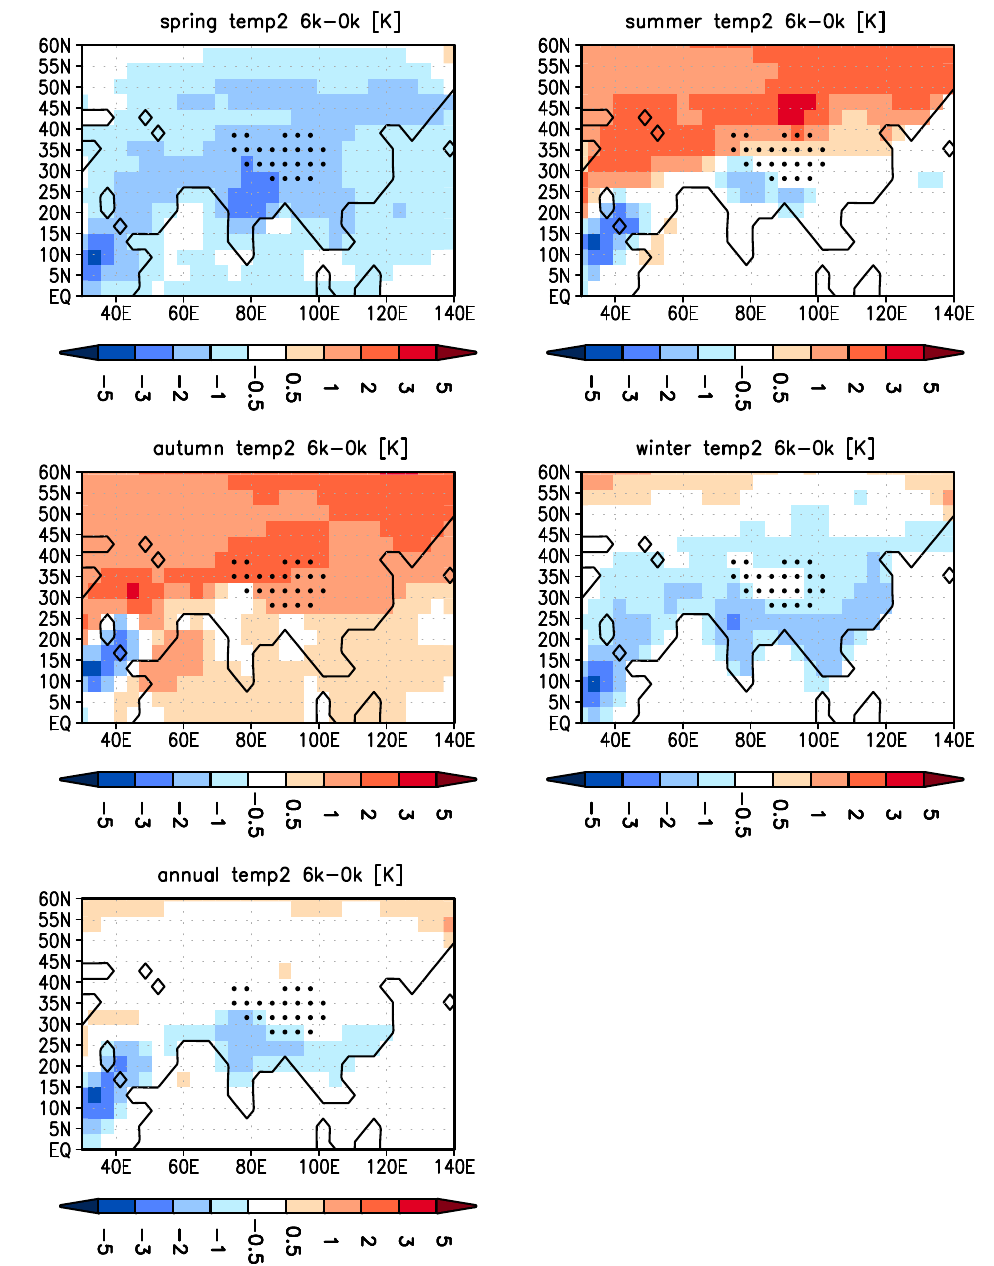
Fig. 2. Seasonal and annual averaged 2m-temperature anomalies [K] between mid-Holocene and present-day climate resulting from the coupled experiment AOV. Seasons are defined on astronomical calendar, based on the time of vernal and autumnal equinox and summer and winter solstice. The annual temperature anomaly is calculated on daily model output. Due to the different length of the respective seasons in mid-Holocene and present-day climate, the annual mean value is not the arithmetic average of the seasons. Stippled area indicates the Tibetan Plateau (orography in the model higher than